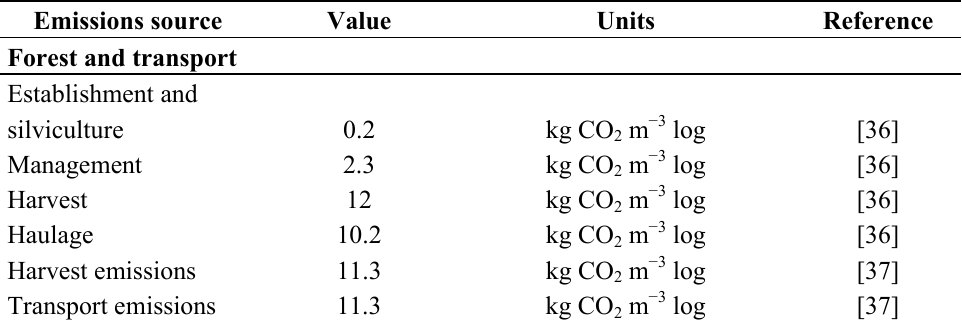
Table 6. Process and landfill handling emissions